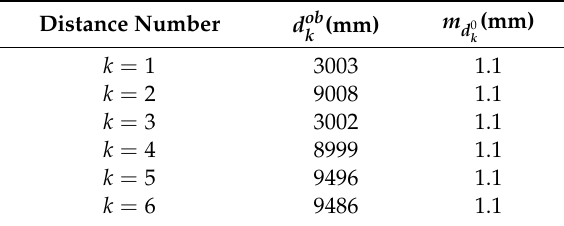
(pseudo-observations). k